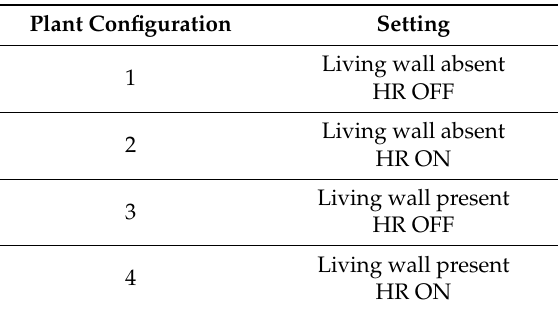
Table 4. Considered plant configurations and related